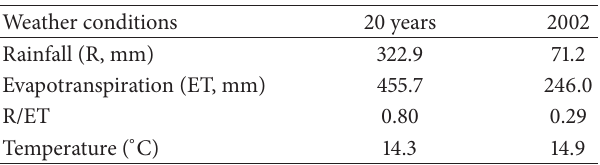
Table1:WeatherconditionsrecordedfromMarchtoAugustin2002 and the mean of twenty last years in Dijon (east of